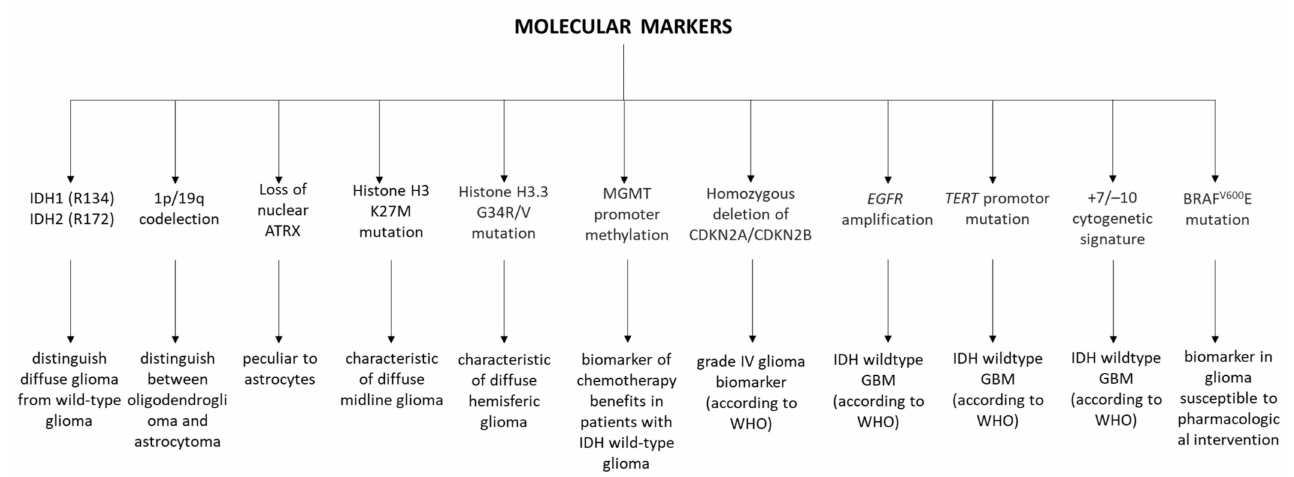
Figure 2. Diagram of molecular markers used in the diagnosis of brain gliomas. Diagram based on [1]. Table 2. Characteristics of selected molecular markers of brain